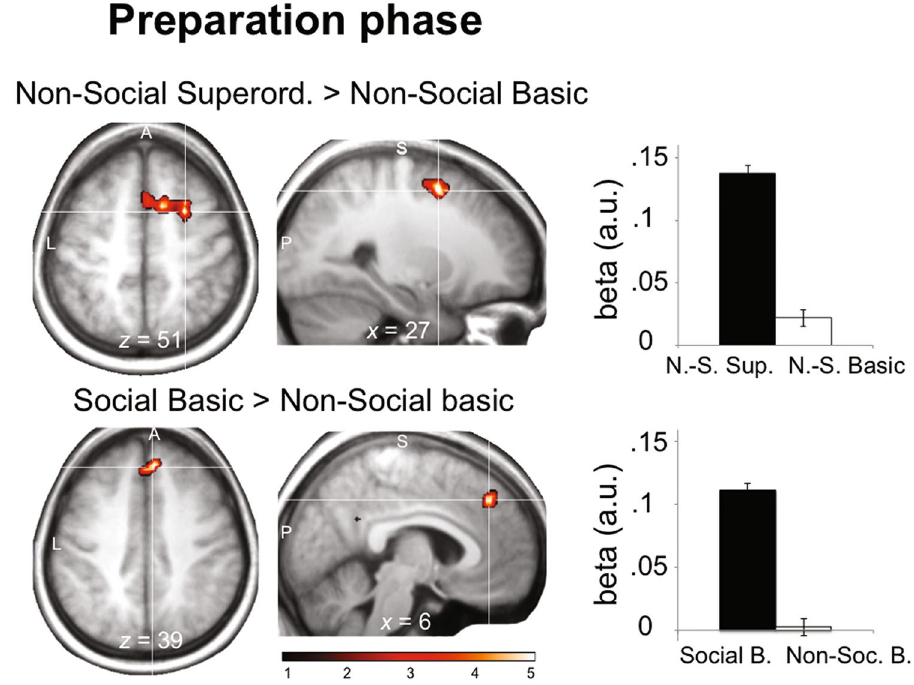
Figure 6. Parametric modulation of BOLD activity by participant’s priors during the preparation phase, for each type of intention. Top panel : Non-Social ‘Superordinate’ vs. Non-Social ‘Basic’ intentions (experiment 1); significant clusters were found in right and medial SMA. Bottom panel : ‘Social’ Basic vs. ‘Non-Social’ Basic intentions (experiment 2); significant cluster was found in the dorsal ACC. Color bar indicates t -statistic